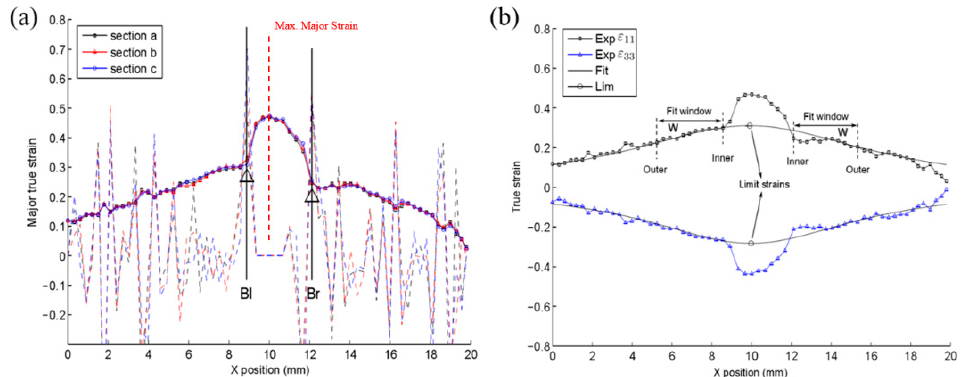
Figure 3. ( a ) Determination of the inner boundary of the fit window, ( b ) Limit strains determined by inverse fit parabola. It was found that the determined strain path ( β exp = ε 11,limit / ε 22,limit ) did not always correspond to the measured strain path ( β exp ), which was measured directly by the